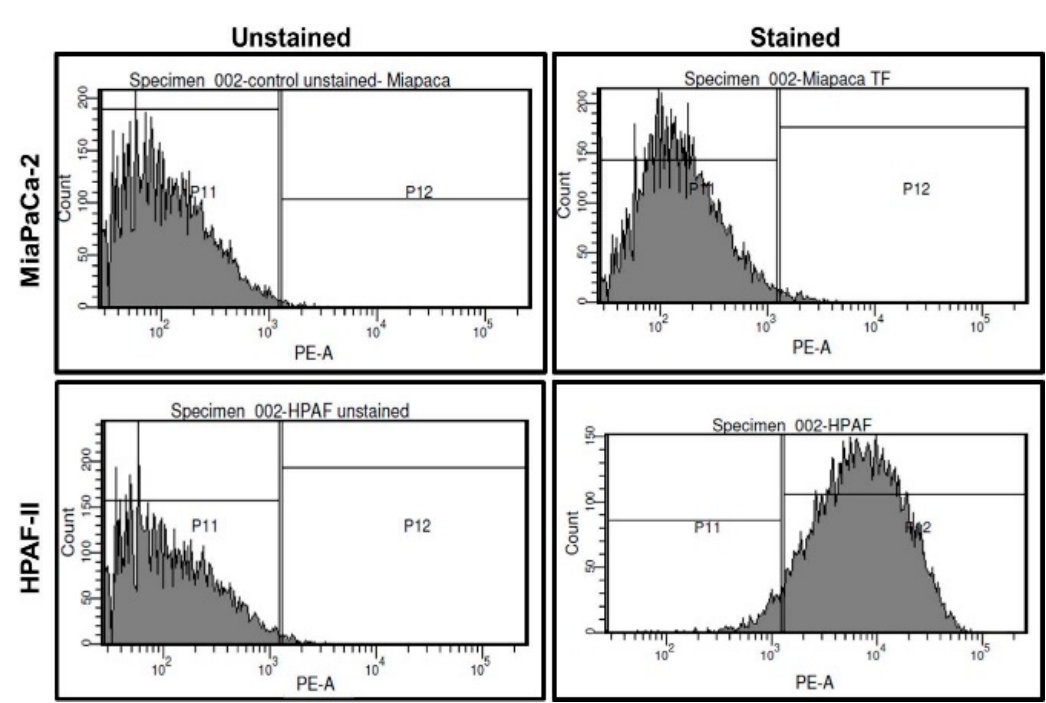
Figure 2. Cont. Figure 3. Cont